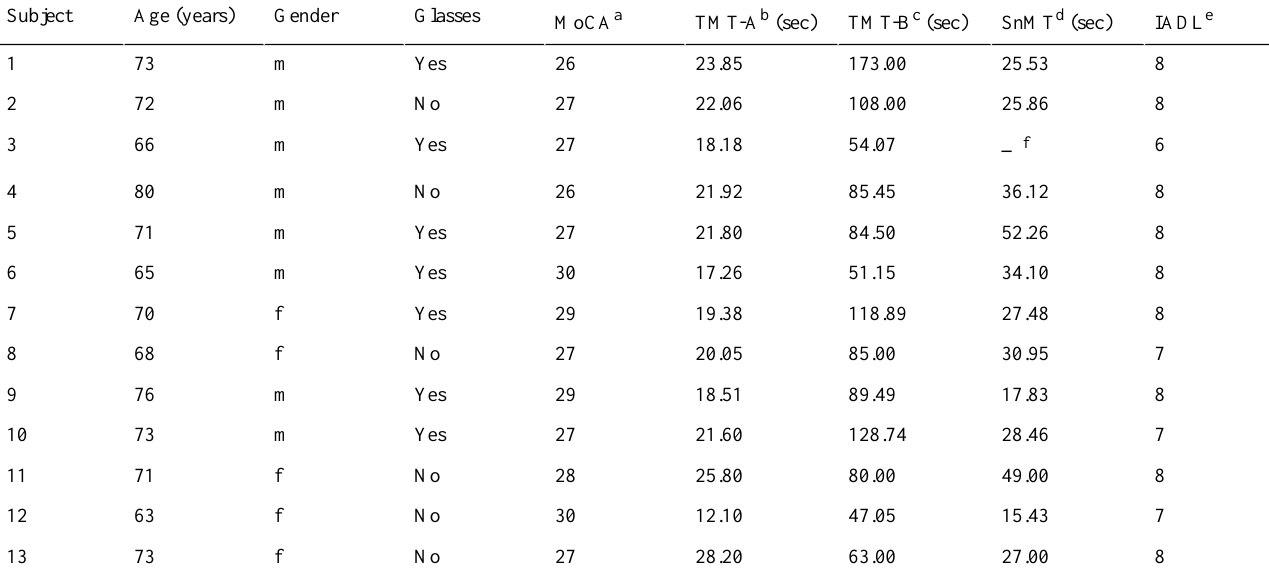
Table 1. Participant characteristics and